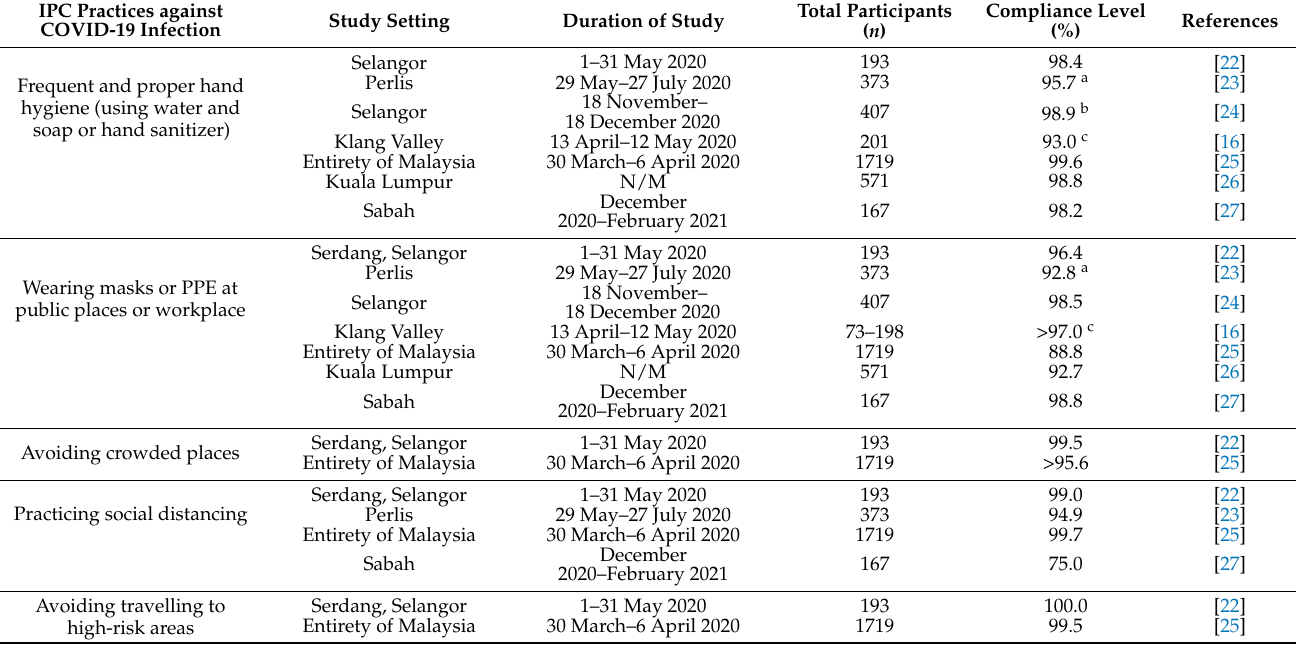
Table 4. Literature survey on IPC measures against COVID-19 among HCWs in